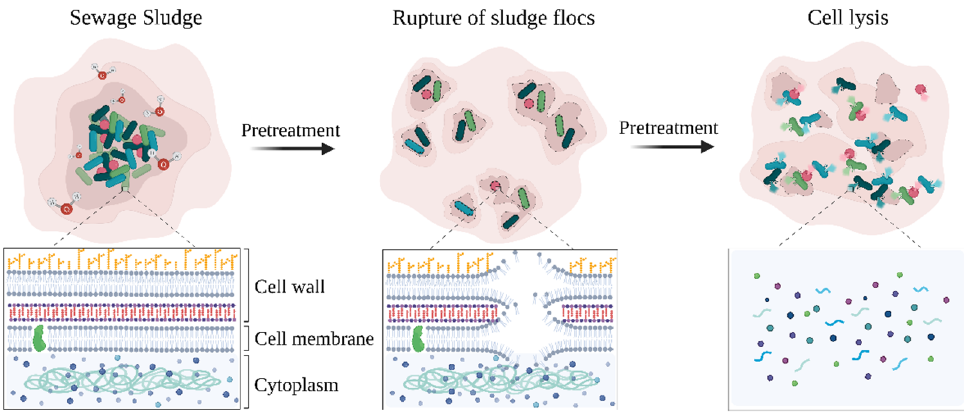
Figure 3. Sewage sludge disintegration, cell lysis, and release of intercellular organic substances due to pretreatment.